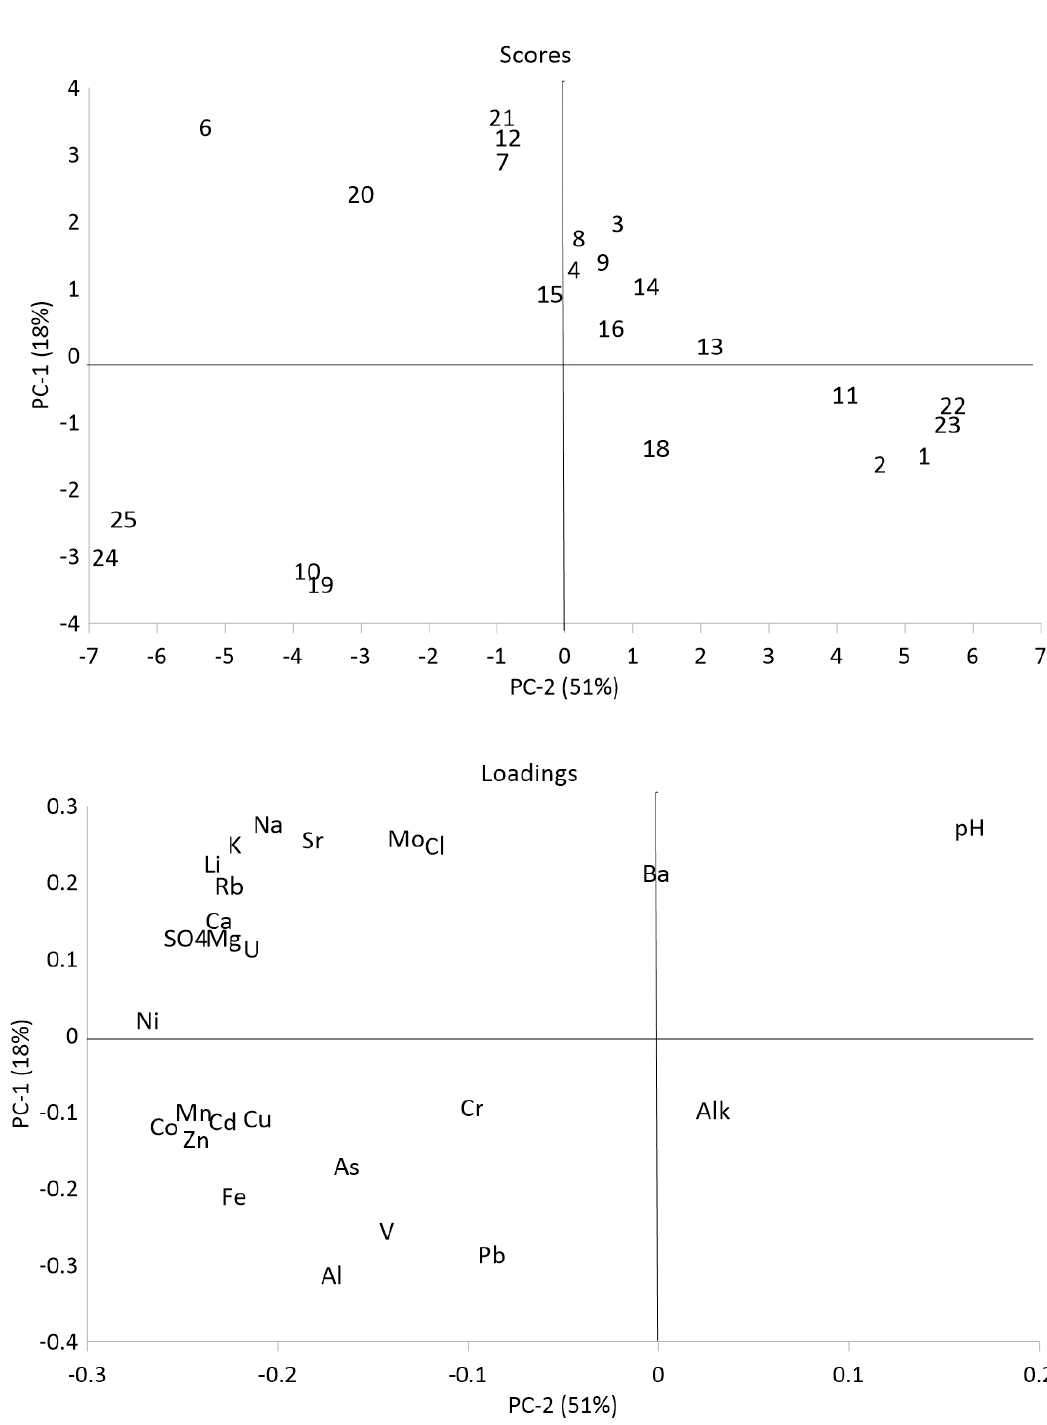
Figure 4. Principal component analysis (PCA) based on samples from all surface water localities sampled on 9 May 2019. Concentrations are normalized and log-transformed prior to calculations.